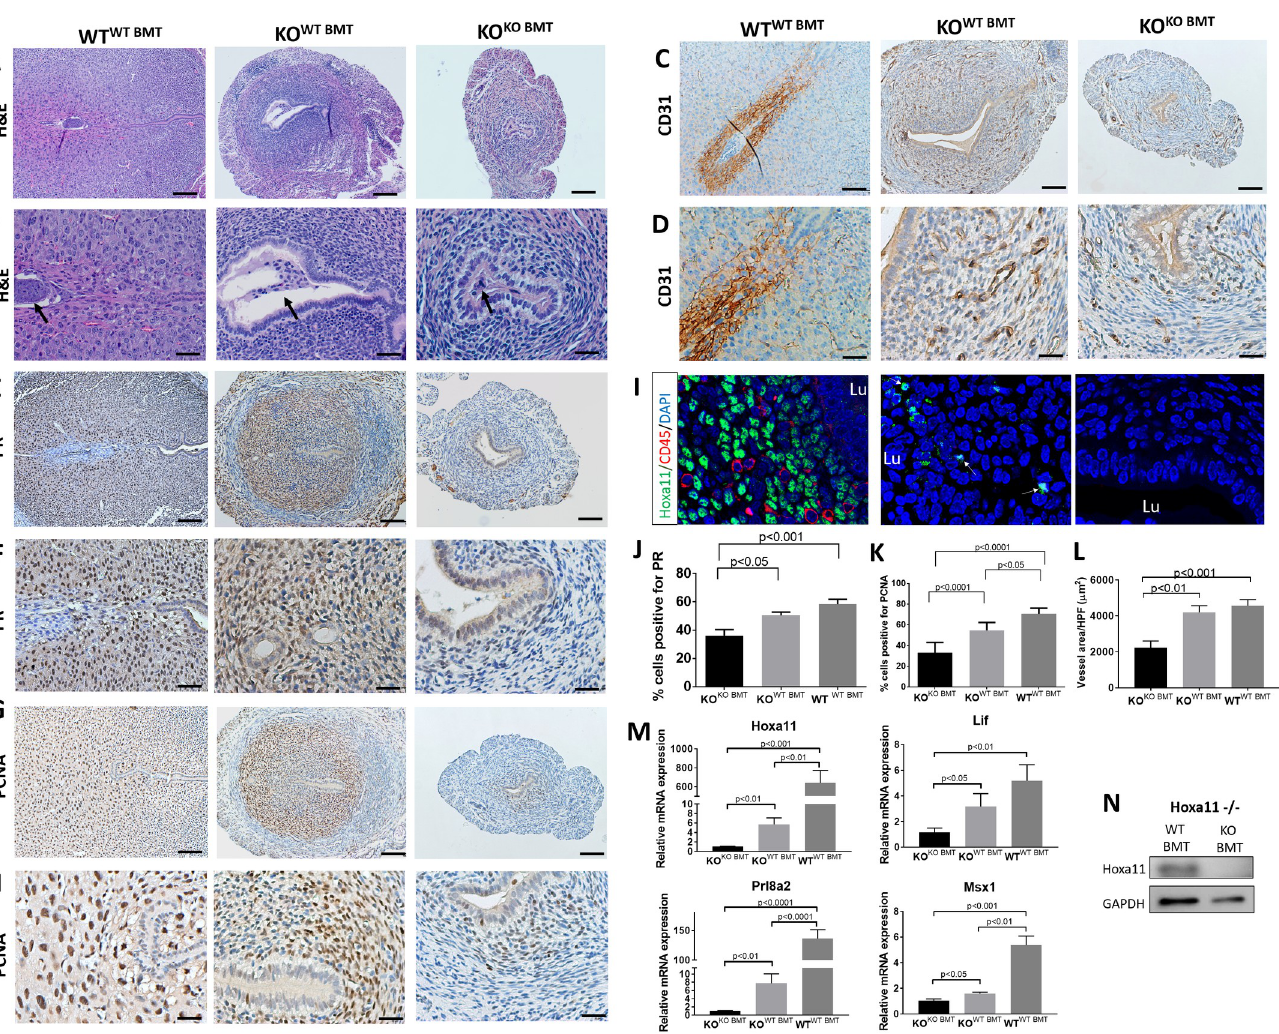
Fig 7. BM transplantation from WT donors leads to decidualization reaction in Hoxa11-null mice. (A-H) Sections of E5.5 implantation sites from WT WT BMT , KO WT BMT , and KO KO BMT stained with HE (A and B), CD31 (C and D), PR (E and F), and PCNA (G and H). B, D, F, and H are higher magnification photomicrographs of A, C, E, and G, respectively. Black arrows point to embryos. (J, K and L) Quantification of pecent PR-positive cells (J), percent PCNA-positive cells (K), and mean blood vessel luminal area ( μ m 2 ) in the endometrium ( n = 3–4 mice/group). (I) Sections of E5.5 implantation sites from WT WT BMT , KO WT BMT , and KO KO BMT co-stained with Hoxa11 (green), CD45 (red), and counterstained with DAPI (blue). Arrows point to Hoxa11-expressing cells. (M) Relative uterine mRNA expression of HoxA11 and implantation-related genes Prl8a2, Lif, and Msx1 normalized to GAPDH in WT WT BMT versus KO WT BMT versus KO KO BMT on E5.5 ( n = 4–5 mice/group). (N) Uterine Hoxa11 protein expression in KO WT BMT versus KO KO BMT on E5.5. Bar graphs represent mean ± SEM. p -values are noted on the graphs. Scale bars, 100 μ m (A, C, E, G), 50 μ m (B, D, F, H). Underlying data are available in S1 Data. BM, bone marrow; BMT, BM transplant;